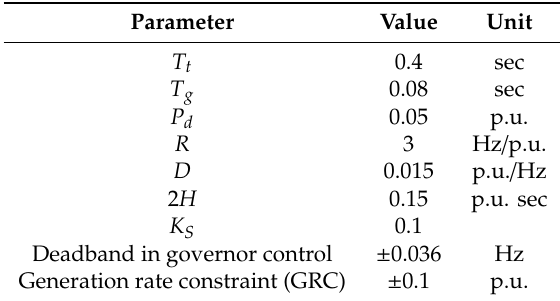
Table 1. Parameters of the test